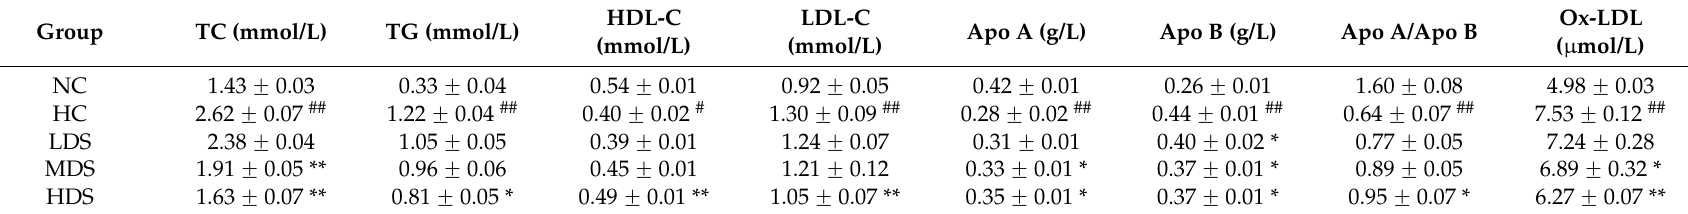
Table 1. Blood lipid levels of rats from different groups after sesamin